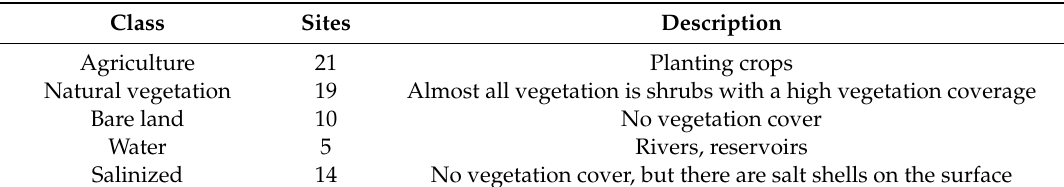
Table 1. Features of the land cover classes.